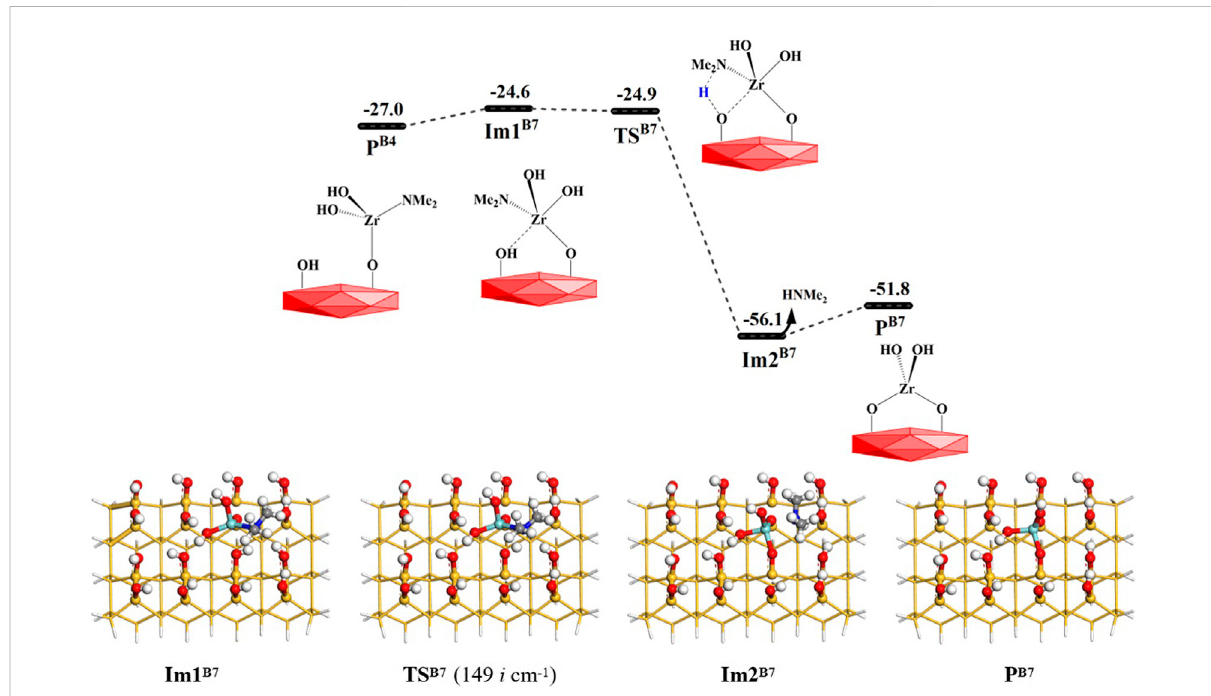
FIGURE 11 Gibbs free energy ( Δ G , kcal/mol) pro fi les of the B7 section of the H 2 O reaction with the aminated